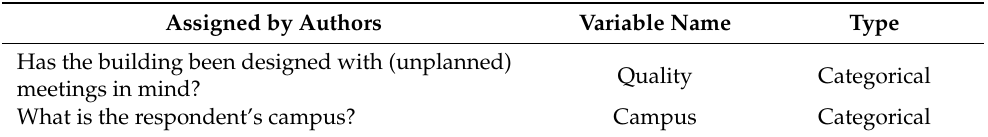
Table 4. Variables assigned by authors.